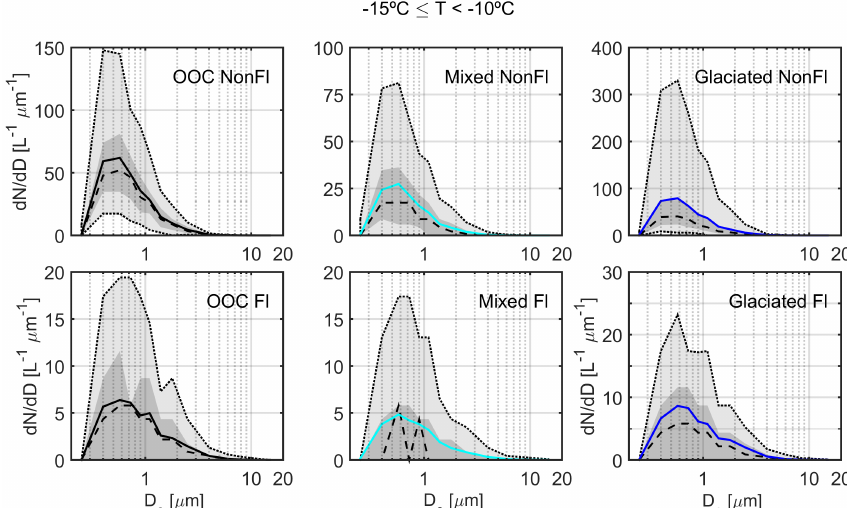
Figure 10. WIBS Non-fluorescent (top panels) and fluorescent particle size distributions (bottom panels) for (left to right panels) out-of- cloud (OOC), mixed-phase, and glaciated conditions over the temperature range − 15 ◦ C ≤ T < − 10 ◦ C. Solid line is mean, dashed line is median; 5th to 95th percentiles and interquartile range shown with light and dark grey areas,